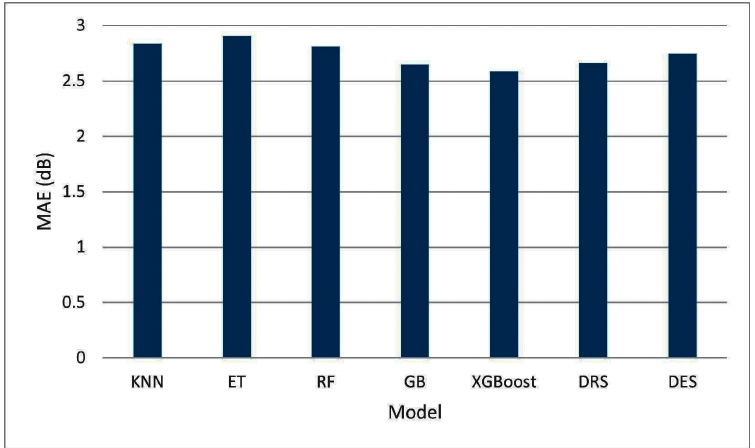
Figure 10. Mean Absolute Error values of models based on dataset 2.